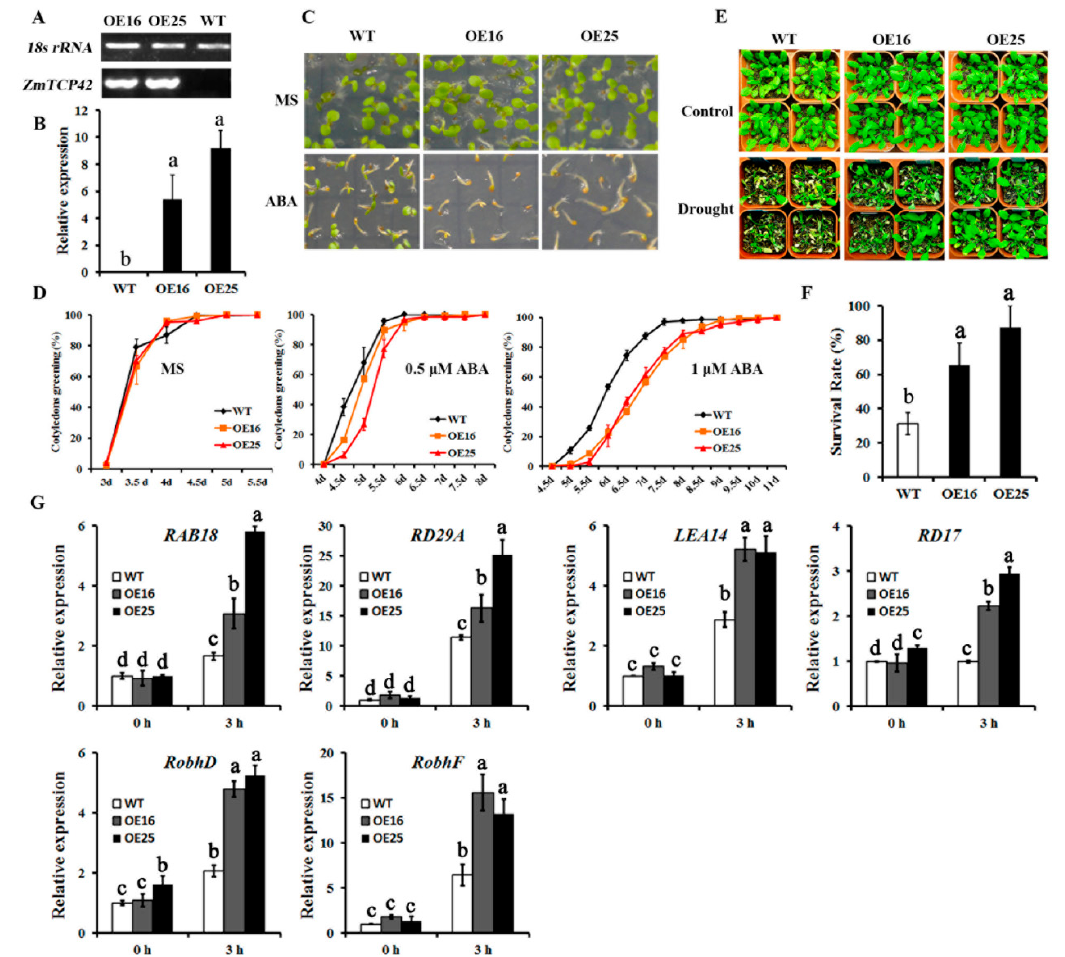
Figure 6. Analysis of wild-type (WT) and ZmTCP42- overexpressing transgenic Arabidopsis plants. ( A ) RT-PCR analysis of ZmTCP42 transcript levels in ZmTCP42 transgenic lines. ( B ) RT-qPCR analysis of ZmTCP42 transcript levels in ZmTCP42 transgenic lines. ( C ) Seed germination of the ZmTCP42 transgenic lines and in the wild-type, in response to abscisic acid (ABA). Germination rates with 1 µ M ABA for 5 days, defined by cotyledon greening, in wild-type ZmTCP42-OE16 and ZmTCP42-OE25 , compared to the MS medium alone. ( D ) Statistical analysis of a green seedling’s rate of ZmTCP42 transgenic lines and wild-type grown on Murashige and Skoog (MS) medium with 0, 0.5 µ M, and 1 µ M ABA. ( E ) Drought tolerance of the ZmTCP42 transgenic Arabidopsis plants. Photographs were taken before and after the drought treatment, followed by 3 days of rewatering. ( F ) Statistical analysis of survival rates after the drought-stress treatment. The average survival rates and standard errors were calculated from three independent experiments. ( G ) RNA levels of stress-responsive genes in the ZmTCP42 transgenic lines and in the wild-type, in response to drought stress. Total RNA was obtained from 3 weeks-old seedlings treated by 3 h of dehydration stress and was analyzed by RT-qPCR, using the gene-specific primers listed in Table S2. The mean value and standard error were calculated from three replicates after normalization to ACTIN2 . The RNA levels in the wild-type grown under non-stress conditions was taken as 1.0. Significant di ff erences were calculated by one-way ANOVA with Duncan’s multiple test (SAS Institute, Inc., Cary, NC, USA). Di ff erent letters indicate a significant statistical di ff erence between the sample means at p = 0.05, while means with the same letters were not significantly di ff